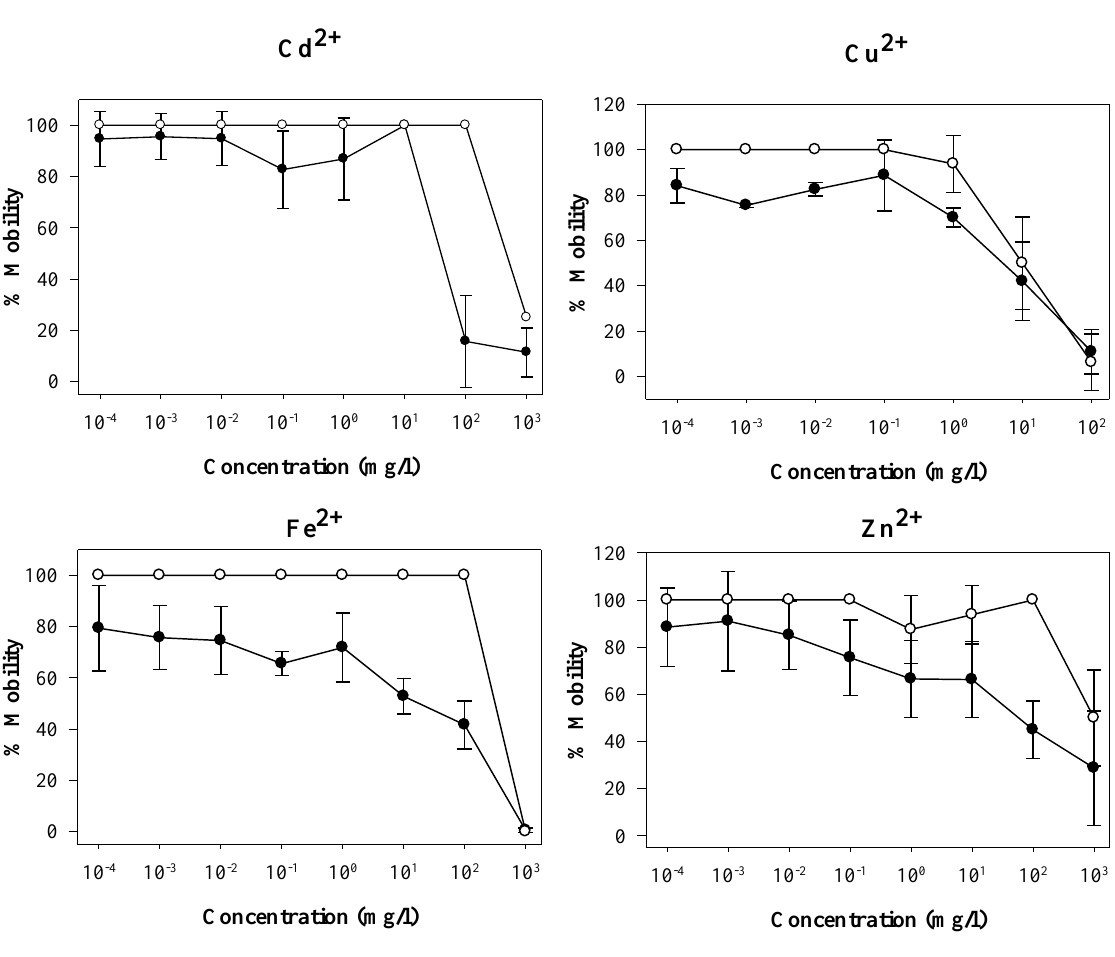
Figure 1. Percentage of (o) hypothetical and (●) measured mobility (using the camera-based instrument) of the Artemia salina nauplii for Cadmium, Iron, Copper and Zinc ions. The error bars represent the standard error from the four replicates of each